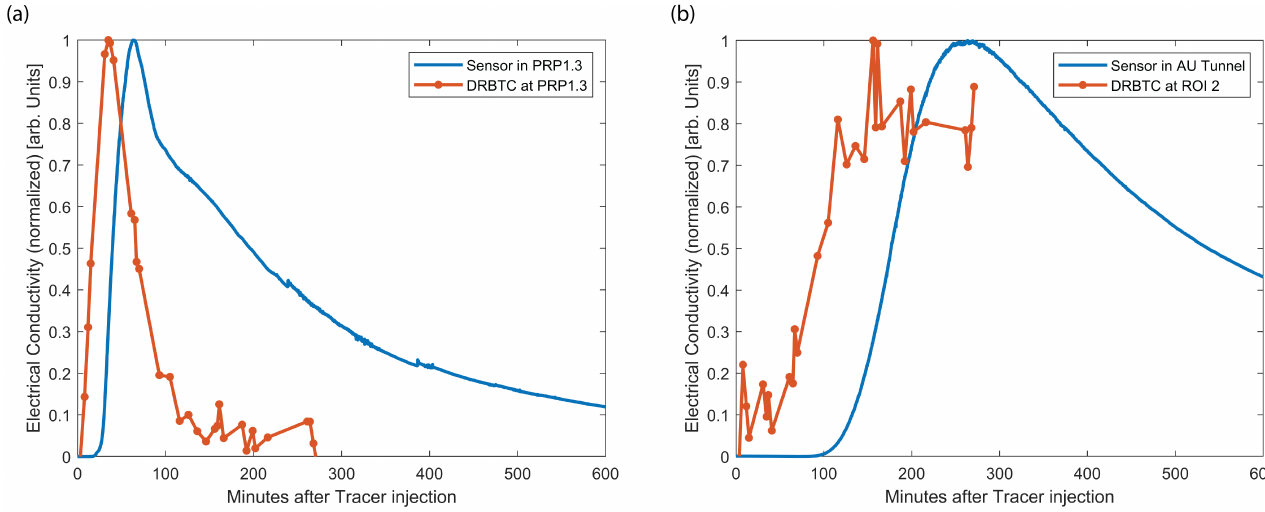
Figure 7. Comparison of the difference radar breakthrough curves (DRBTC) and sensor breakthrough curve (BTC) during Experiment 1. ( a ) Shows the data for the PRP1.3 interval and the accordingly defined ROI. ( b ) Shows the DRBTC for ROI 2 and the conductivity sensor BTC for the AU tunnel outflow (which is not at the same location as ROI